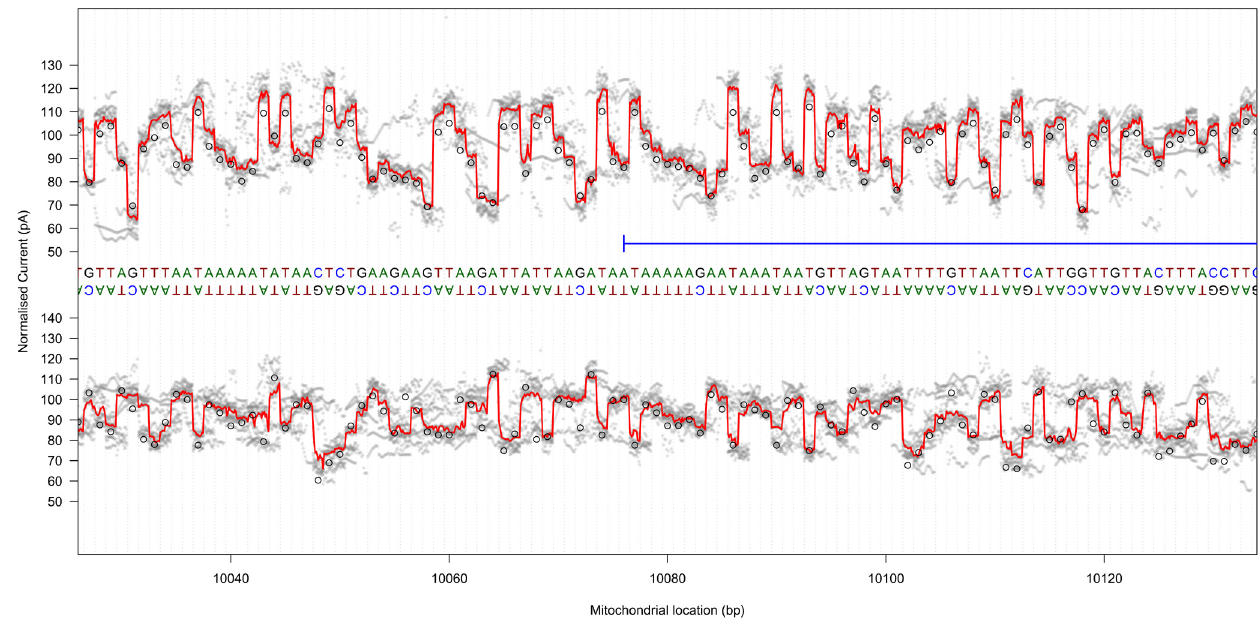
Figure 5. Raw signal plot, CytB gene head. Raw signal plot for 100 bases at the start of the Cytochrome B gene for template read directions (top) and complement read directions (bottom). Median raw signal current is shown as a thick red line, with individual raw signal observations shown in grey. Ideal event current for the observed pentamers is shown as black